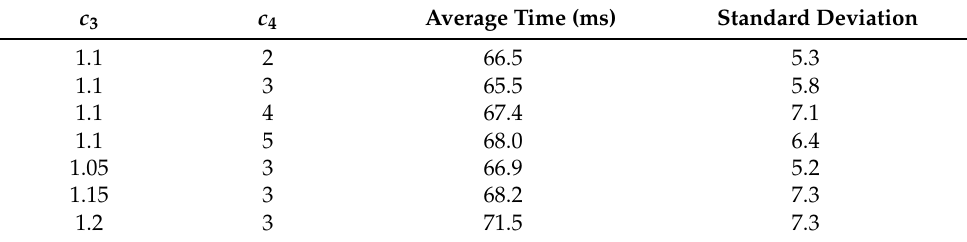
Table 3. Time efficiency with different c 3 and c 4